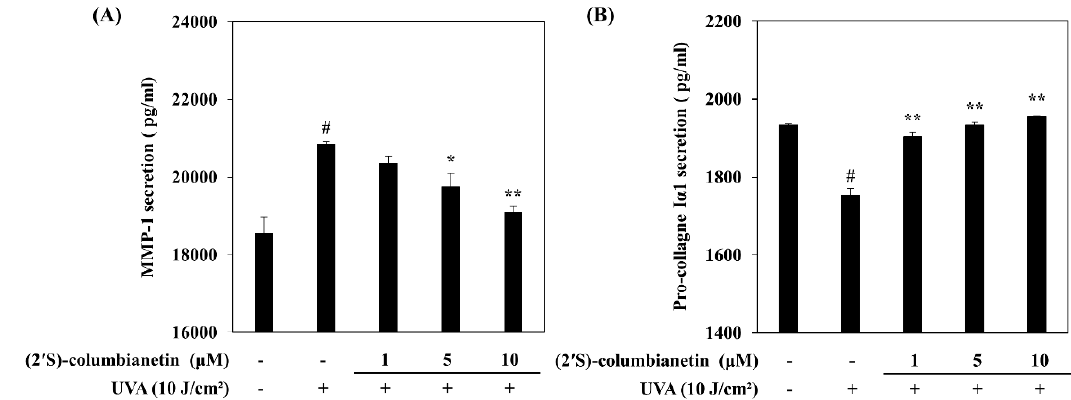
Figure 3. Effect of (2 ′ S)-columbianetin on the cellular release of MMP-1 ( A ) and type I α 1 pro-collagen ( B ) in UVA-irradiated HDFs. The contents of MMP-1 and type I α 1 pro-collagen were calculated from UVA-irradiated cell culture media following 24 h incubation with different concentrations of (2 ′ S)-columbianetin using ELISA. Values are means ± SD ( n = 3). # p < 0.01 compared to non-irradiated blank group; * p < 0.05, ** p < 0.01 compared to UVA-irradiated untreated control group.